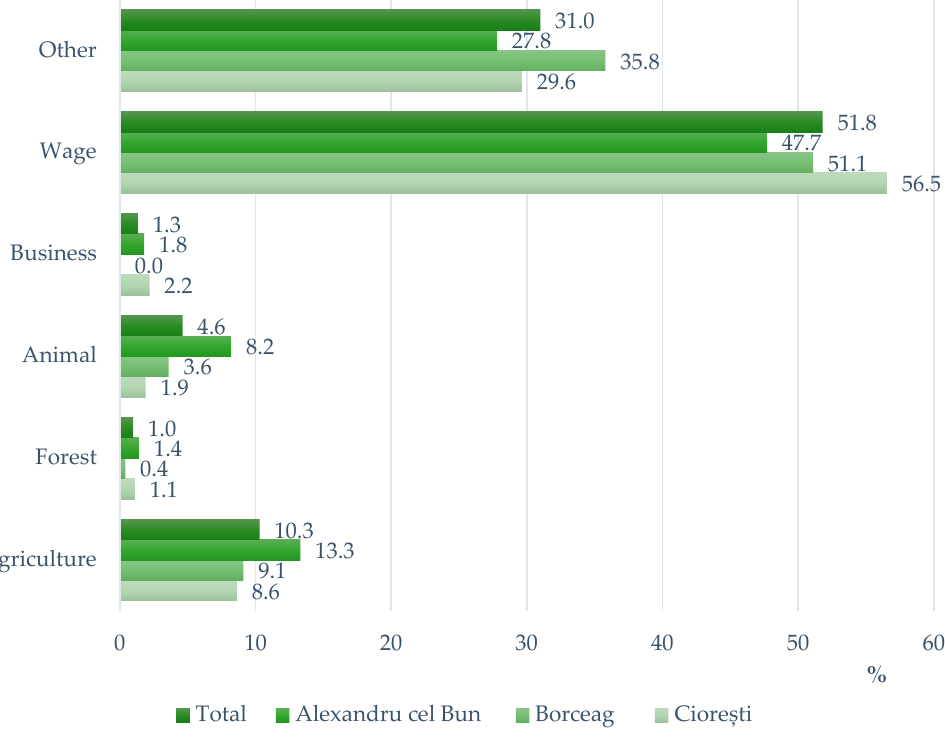
Figure 4. Annual sources of income and their share of total income.